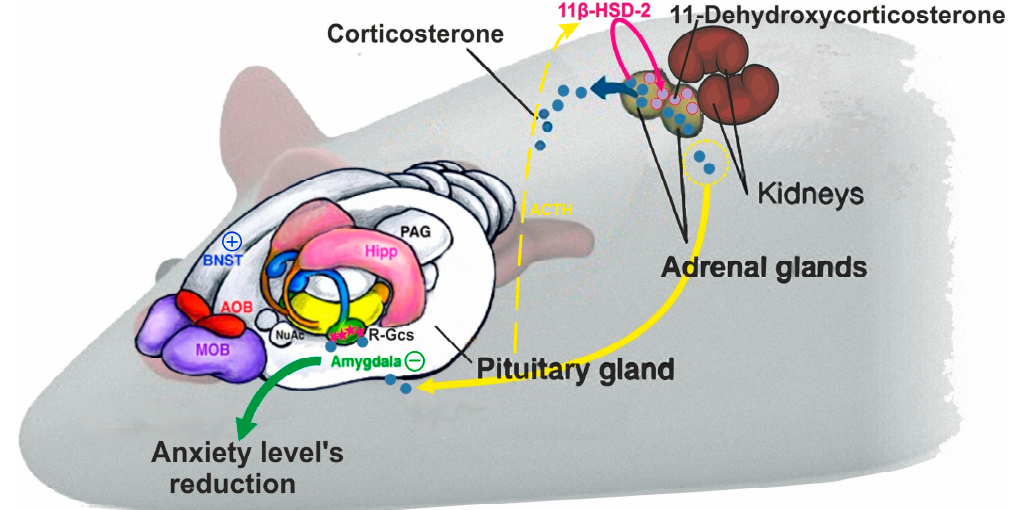
Figure 4. Parallel behavioral and brain biochemical changes in AFR rats. Legend: Hypocorticosteronemia in AFR rats develops as a result of corticosterone inactivation by 11 β HSD2 in the adrenal glands. Low corticosterone levels contribute to inhibition of amygdala activity, which manifests as a decrease in glutamate (Glu)/glutamine (Gln) ratio and an increase in lactate (Lac) in this brain structure [3]. A parallel increase in the excitatory neurotransmitter Glu+Gln in the striatum possibly indicates activation of this brain structure. Inhibition of the amygdala and activation of the striatum possibly lead to a decrease in the anxiety of AFR rats. The observed decrease in corticosterone is most likely transient and rapidly restorable. The red stars indicated “R-Gcs” (Gluccocorticoid receptors of the